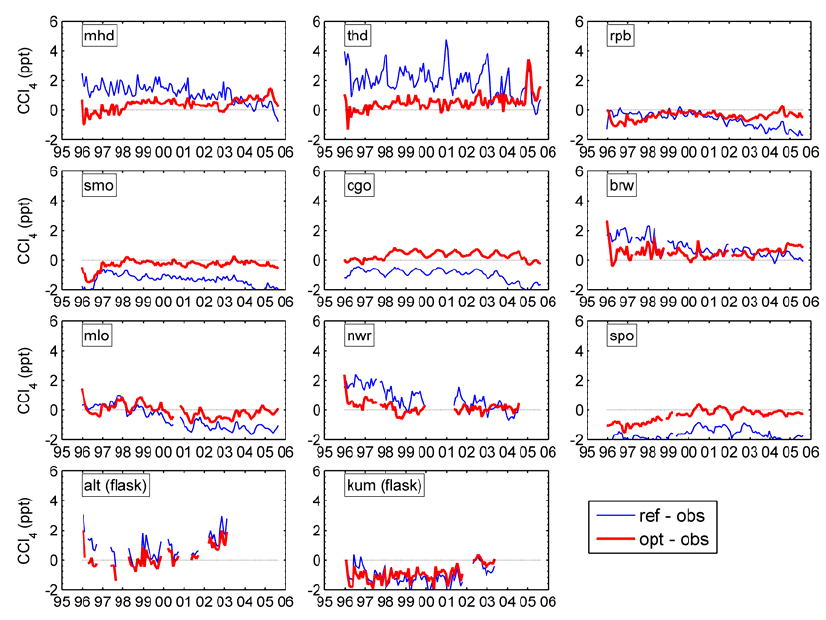
Fig. 11. Residuals between the optimized and observed monthly mean mole fractions of CCl 4 (red thick lines), compared to the residuals between the reference and observed monthly mean mole fractions (blue lines) at each observing site.